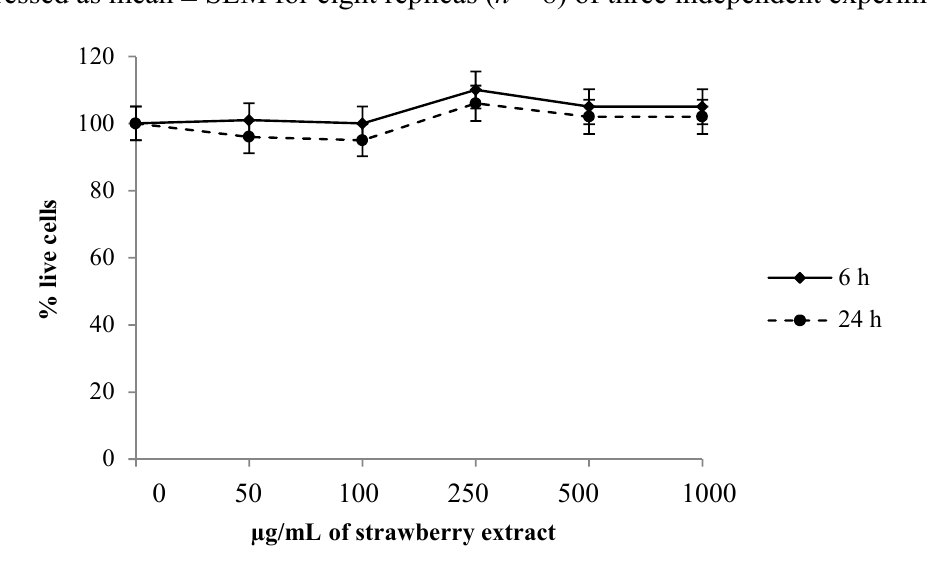
Figure 2. Viability of Human Dermal fibroblast (HuDe) determined by MTT assay after incubation with H O . Control and strawberry pre-treated cells (0.5 mg/mL) were stressed 2 2 O (0–50 mM). Cells with extract differ significantly with various concentrations of H 2 2 from controls for concentrations of H O between 0.5 and 5 mM. Data are expressed as 2 2 mean ± SEM for eight replicas ( n = 8) of three independent experiments. * p < 0.05 significantly different from